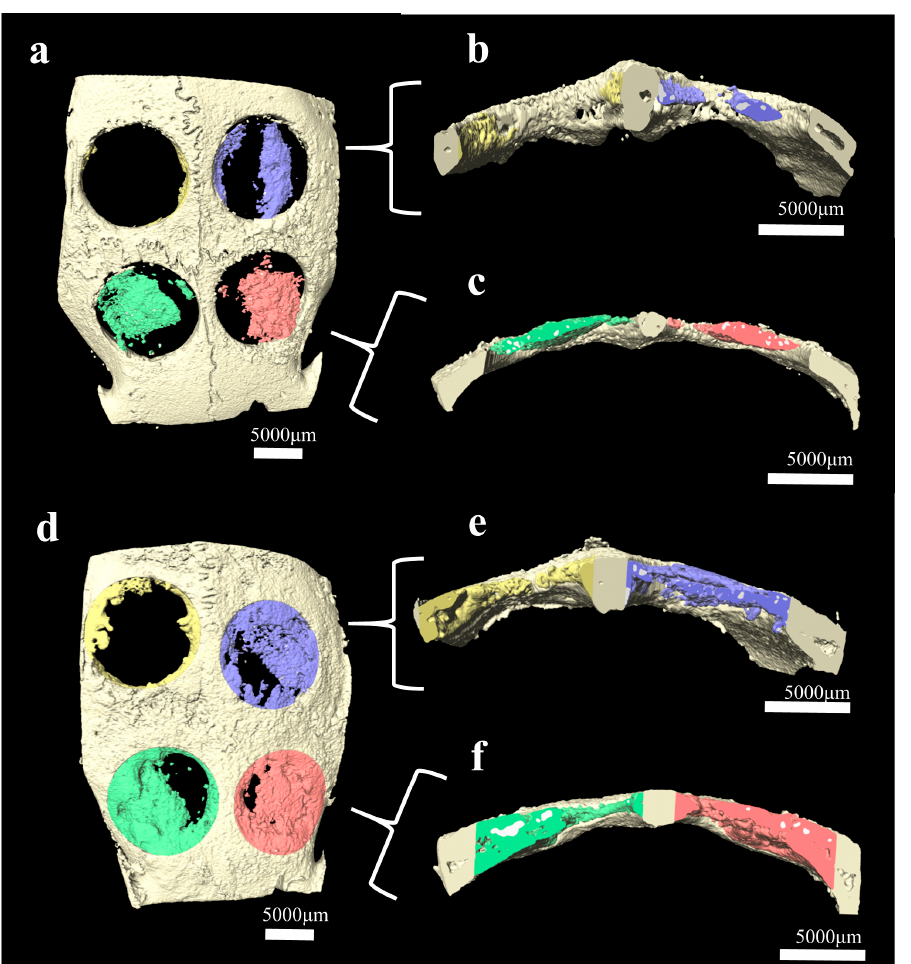
Figure 4. Comparison of regenerated new bone volume at 2 weeks ( a – c ) and eight weeks ( d – f ) after surgery. The defects from the four groups are represented in different colors as follows: the NC group (yellow), HA group (blue), TiO 2 -coated HA group (green), and TiO 2 -coated HA with UV group (red). 3D visualization of a rabbit calvarial defect specimen acquired by micro-CT for ( a , d ) a whole specimen containing new bone and substitutes, ( b , e ) cross-section image of the NC group and HA group, and ( c , f ) cross-section image of the TiO 2 -coated HA group and TiO 2 -coated HA with UV group.